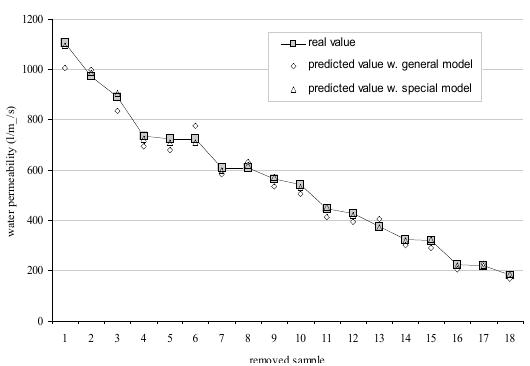
Fig. 7. Comparison general/special models, related to water permeability From these experimental results, we can see that the special model gives lower prediction errors (averaged error: 1.60%) than the general model (averaged error: 6.55%). This observation can be explained as